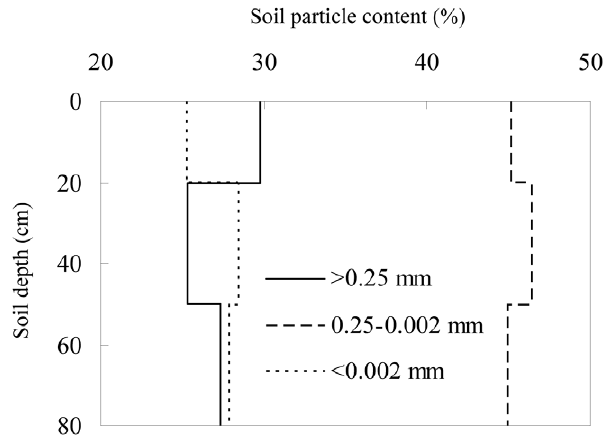
Figure 1. Soil particle distribution in the study site.